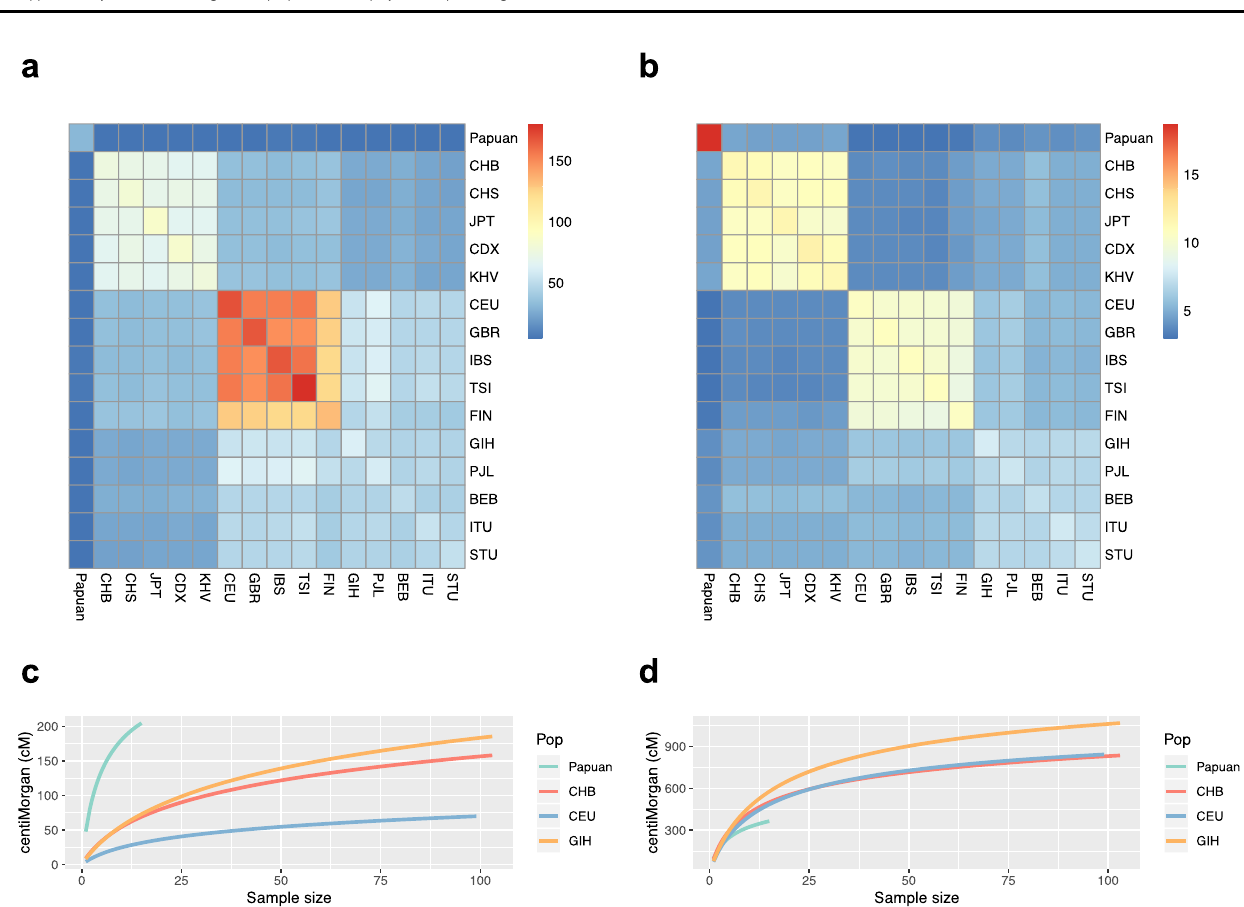
Fig. 4 Ancestry-sharing ratio and introgression diversity. a Ancestry-sharing ratio of Denisovan-like introgressed sequences. b Ancestry-sharing ratio of Neanderthal-like introgressed sequences. The heatmap of genomic introgression position shares statistics among worldwide populations. Warm colors indicate more sharing of the introgression position and cold colors indicate less sharing. c Introgression diversity of Denisovan-like introgressed sequences. d Introgression diversity of Neanderthal-like introgressed sequences. The y -axis shows the total introgressed sequence length and the x -axis shows the sample size. To avoid sampling errors, 10,000 permutations were performed. CHB Han Chinese from Beijing, China; CHS Han Chinese from South China; JPT Japanese from Tokyo, Japan; CDX Chinese Dai from Xishuangbanna, China; KHV Kinh from Ho Chi Minh City, Vietnam; CEU Utah residents with Northern and Western European ancestry CEPH collection; GBR British from England and Scotland; IBS Iberian populations in Spain; TSI Tuscans in Italy; FIN Finnish in Finland; GIH Gujarati Indians from Houston, Texas, United States; PJL Punjabi from Lahore, Pakistan; BEB Bengali in Bangladesh; ITU Indian Telugu from the UK; STU Sri Lankan Tamil from the UK.